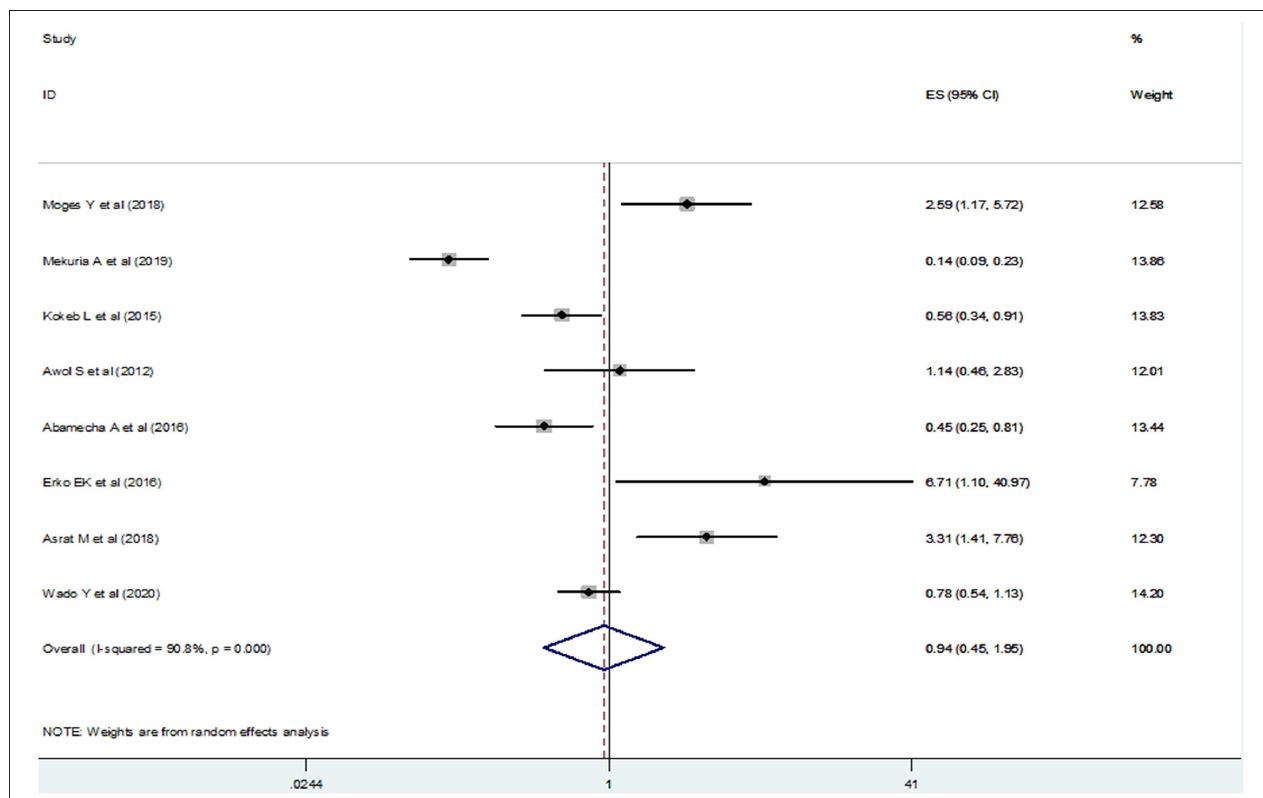
FIGURE 9 | The pooled odds ratio of the association between maternal marital status and post-abortion contraceptive utilization in Ethiopia.